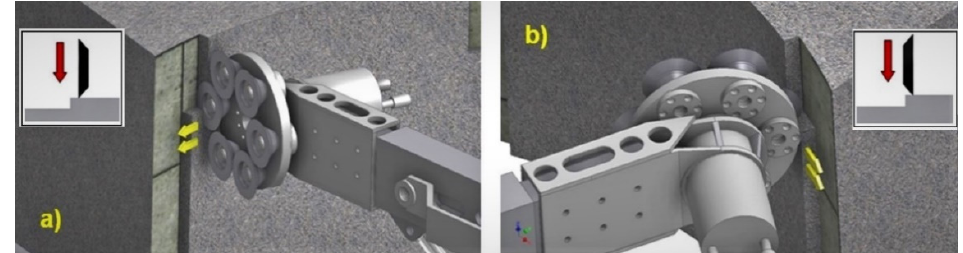
Figure 14. The scheme of vertical mining of the sample: ( a ) from left edge, ( b ) from right edge [2,30]. [2,30].